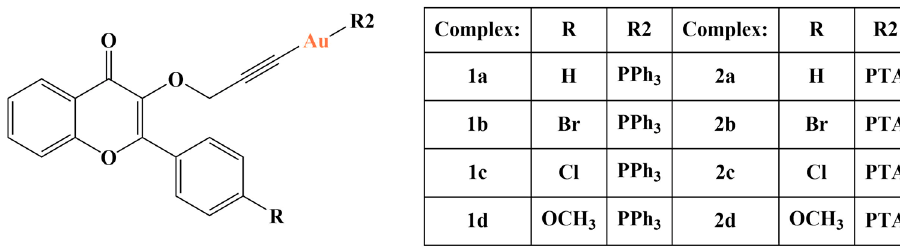
Figure 30. One of the complexes presented in [113].